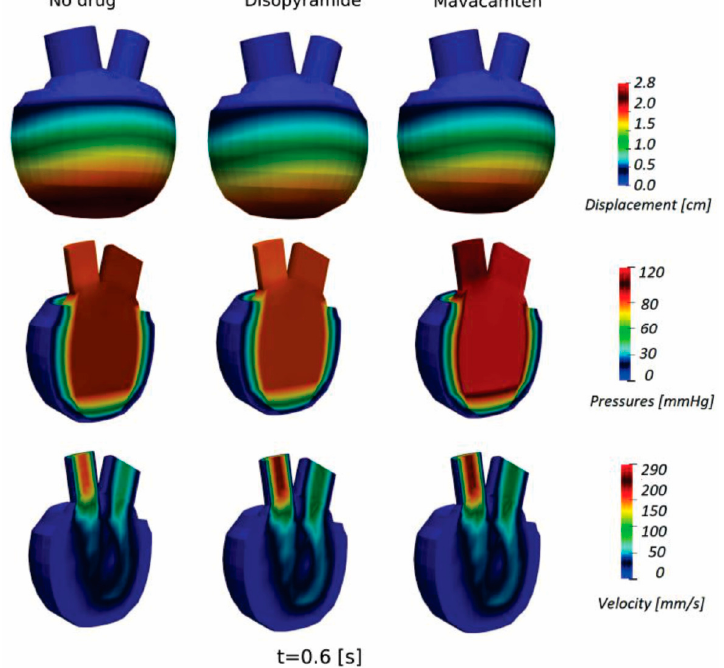
Figure 16. Displacement, pressures, and velocity distribution (peak systole, t = 0.6 s) for HCM at basic condition (without administered drug) and with using Disopyramide and Mavacamten.